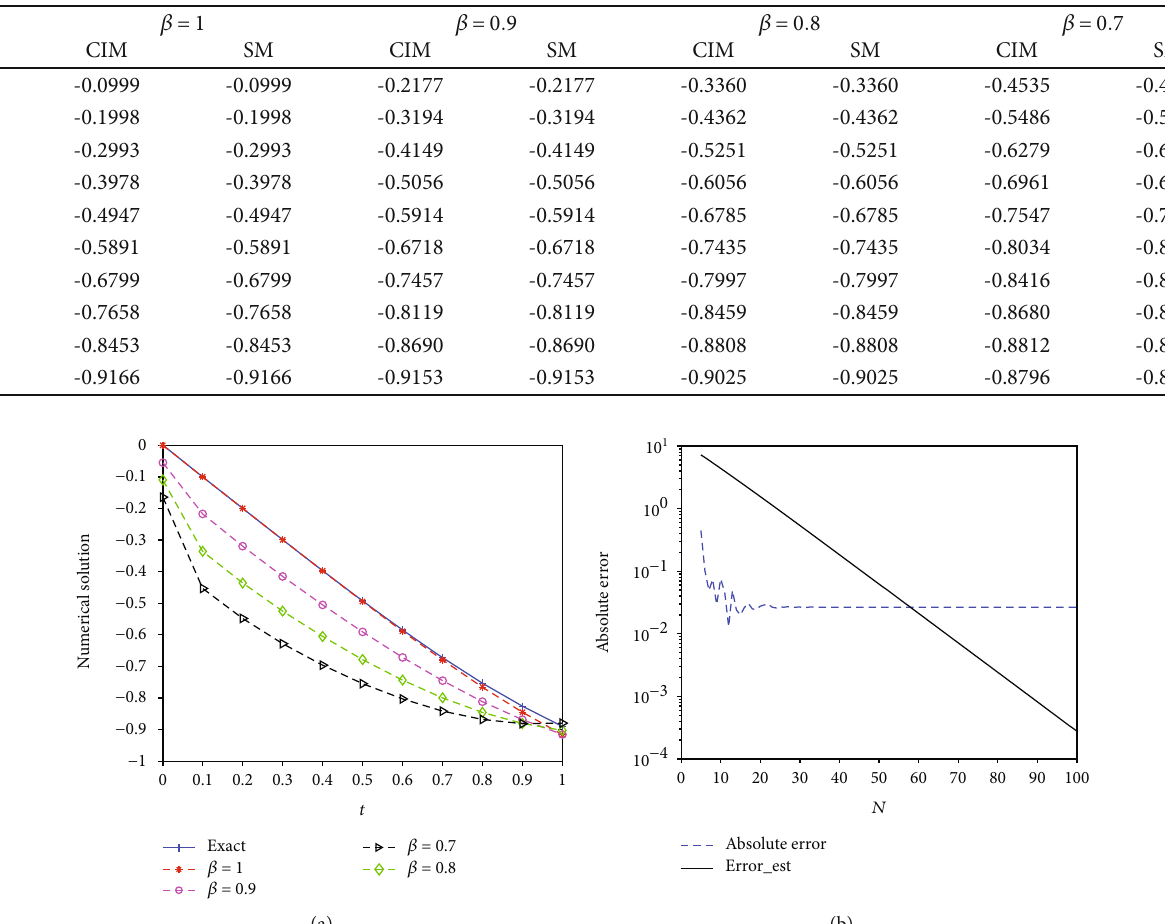
Figure 3: In (a), the graphs of numerical solutions for di ff erent values of β corresponding to Problem 2 are shown. In (b), the absolute error vs. error estimates for β = 1 are